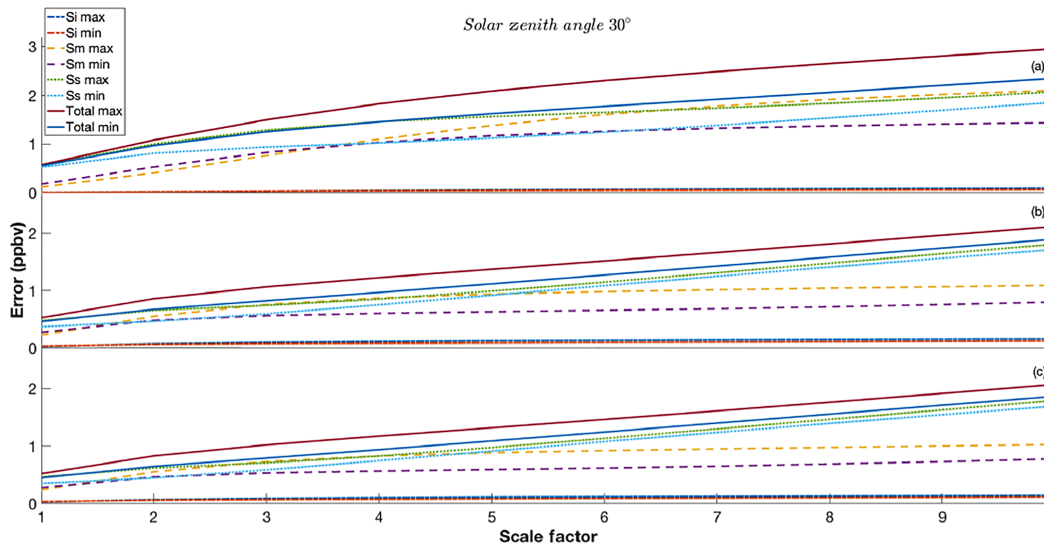
Figure 7. Synthetic total column retrieval errors for scenarios outlined in Table 3, based on Eqs. (8), (9), (10) and (16). The maximum and minimum values (based on maximum and minimum SNR) for interference, measurement and smoothing error are shown, in addition to the total error: panel (a) indicates scenario 1, panel (b) indicates scenario 4 and panel (c) indicates scenario